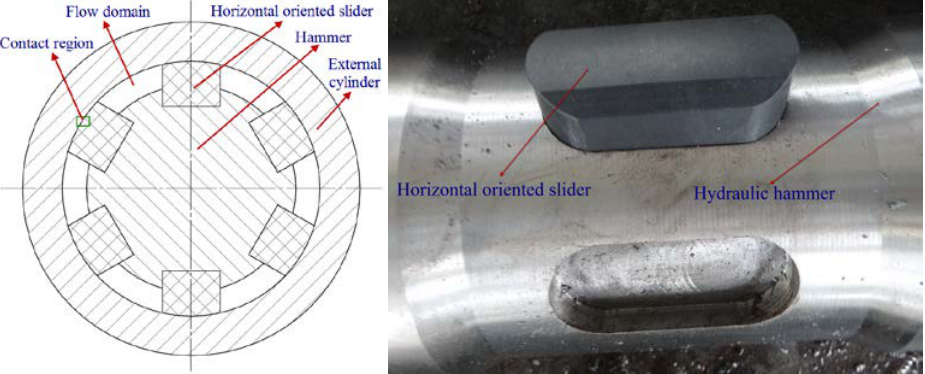
Figure 1: Structure of hydraulic DTH hammers with horizontal oriented